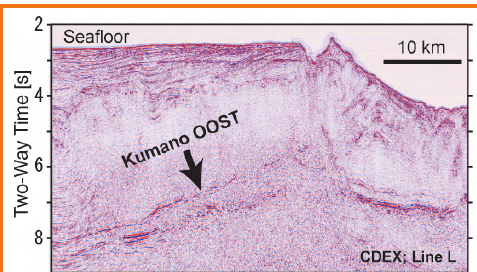
Figure 2. Out-of-sequence thrust on seismic reflection profile off Kumano. This profile crosses the planned IODP